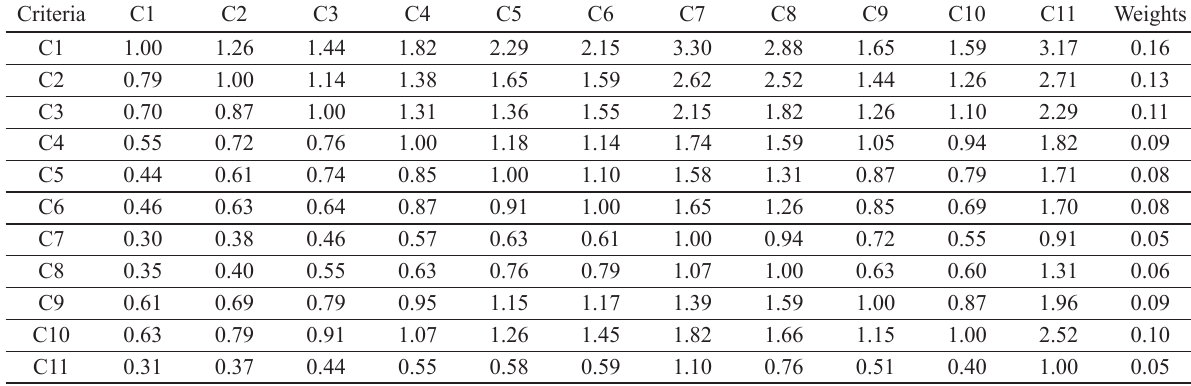
Table 3. Pairwise comparison matrix for criteria and results obtained from AHP computations